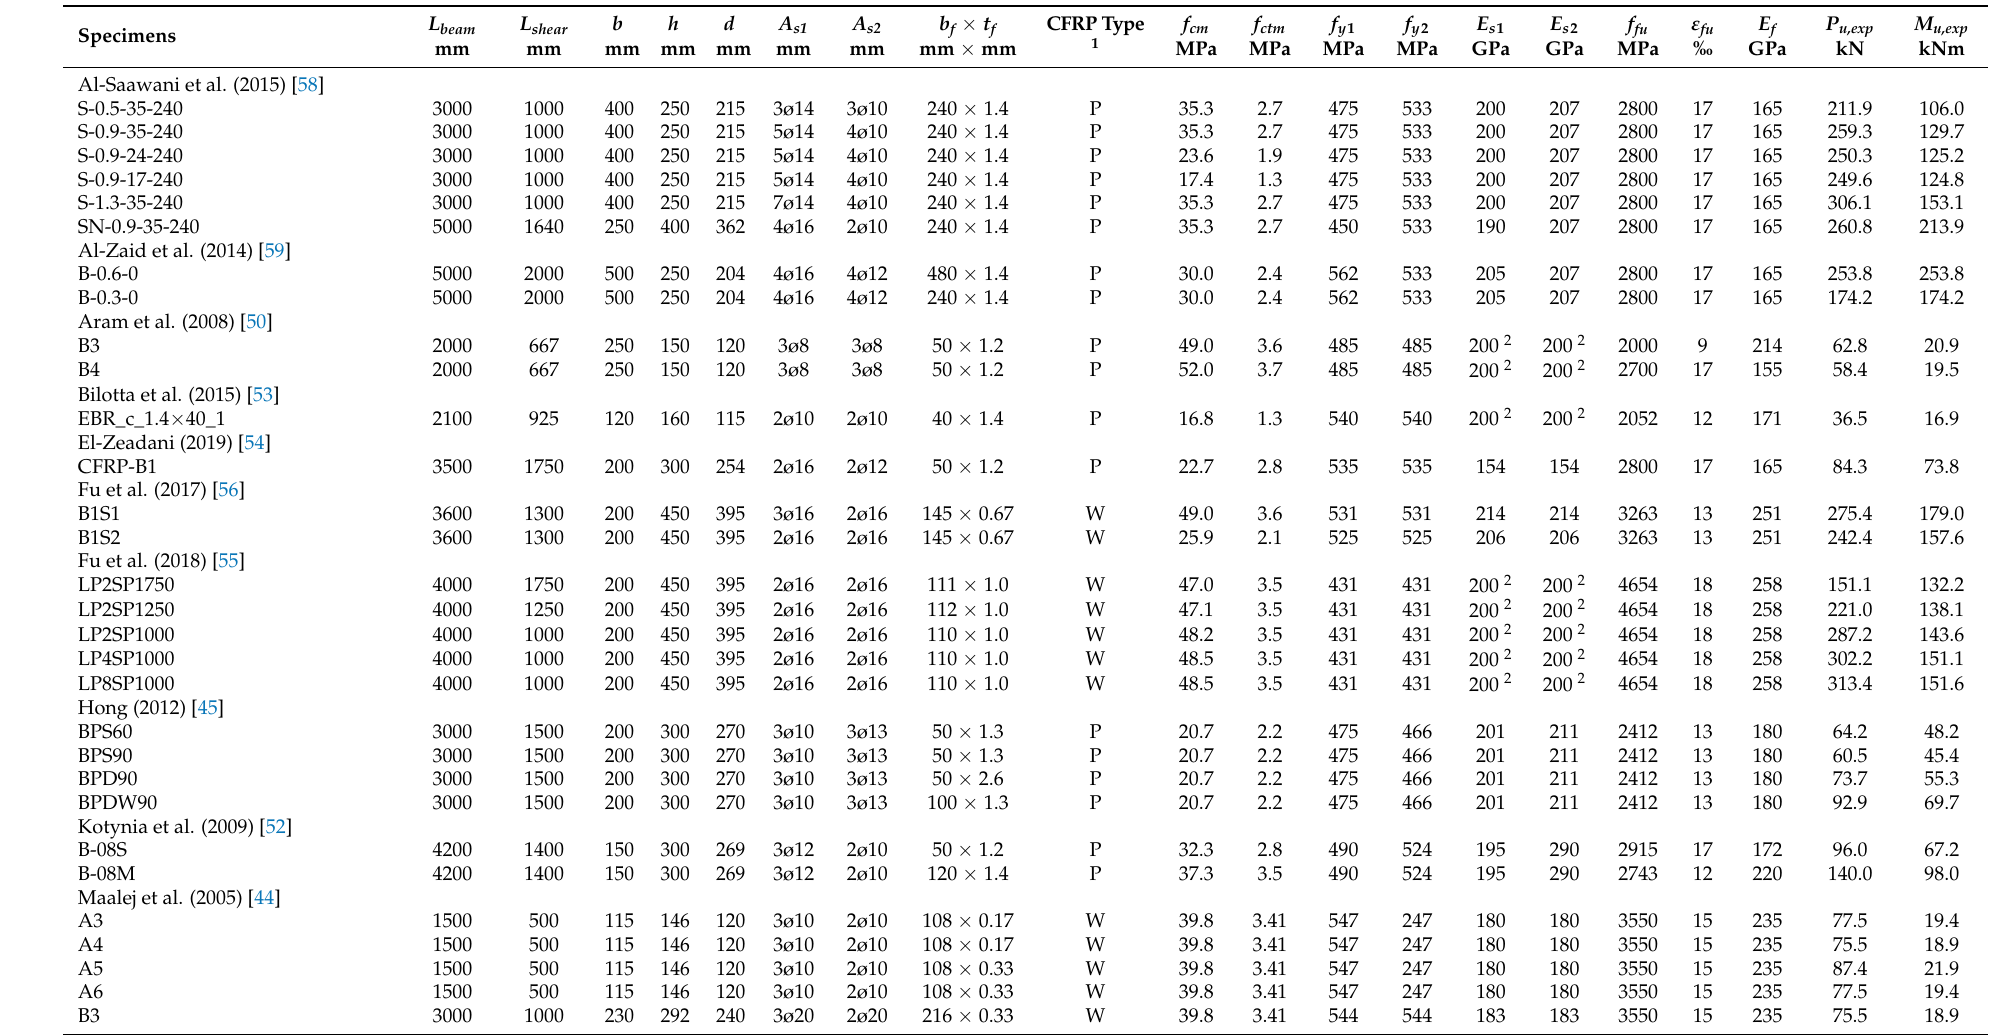
Table 6. Geometrical and material properties for the specimens in the